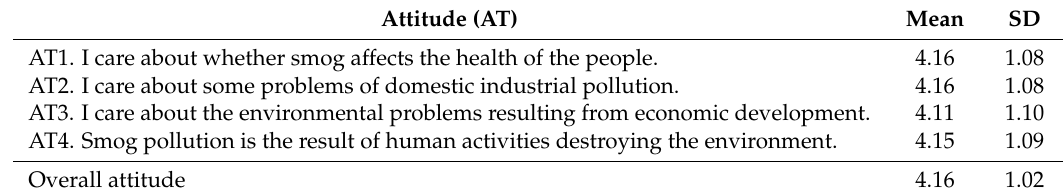
Table 6. Descriptive statistics for attitude (AT)-related items. Attitude (AT)